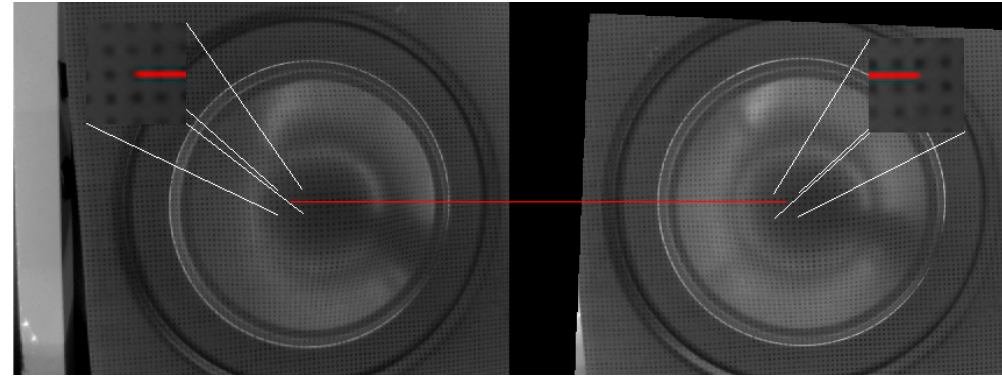
Figure 1. Global correlation with an error of image registration transform.